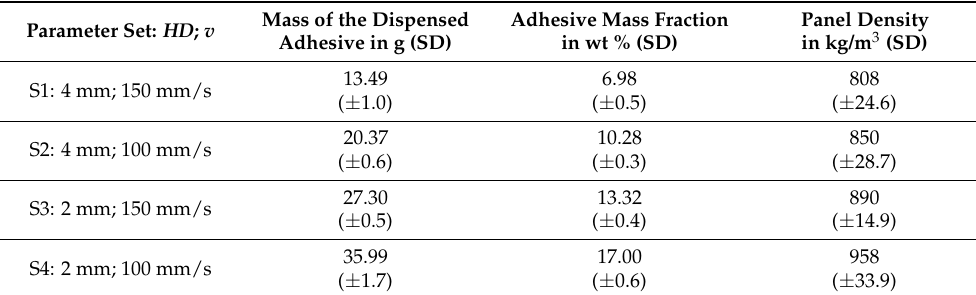
Table 4. Summary of the dispensed adhesive and the density values of the panels. Values in brackets are the standard deviations